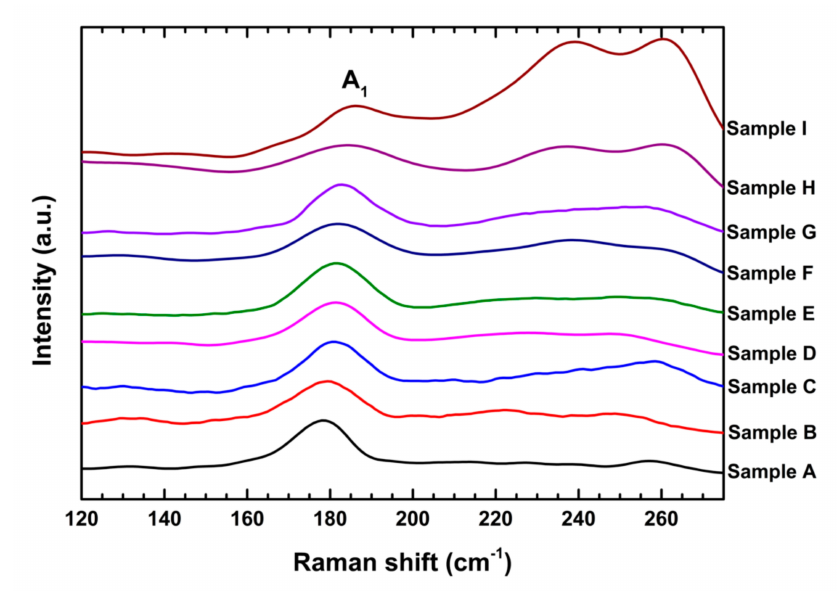
Figure 6. Raman spectra of CuIn 1 − x Ga x Se 2 nanocrystals.